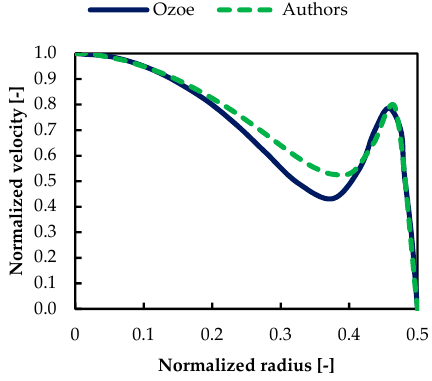
Figure 4. Comparison between literature results based on Ozoe [15] and the authors’ results: Normalized velocity profile versus normalized pipe radius.